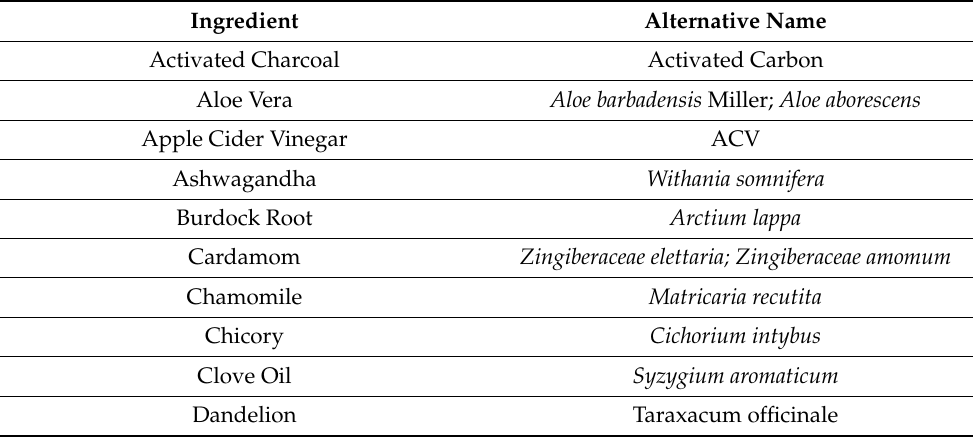
Table 1. Ingredients of interest with alternative naming